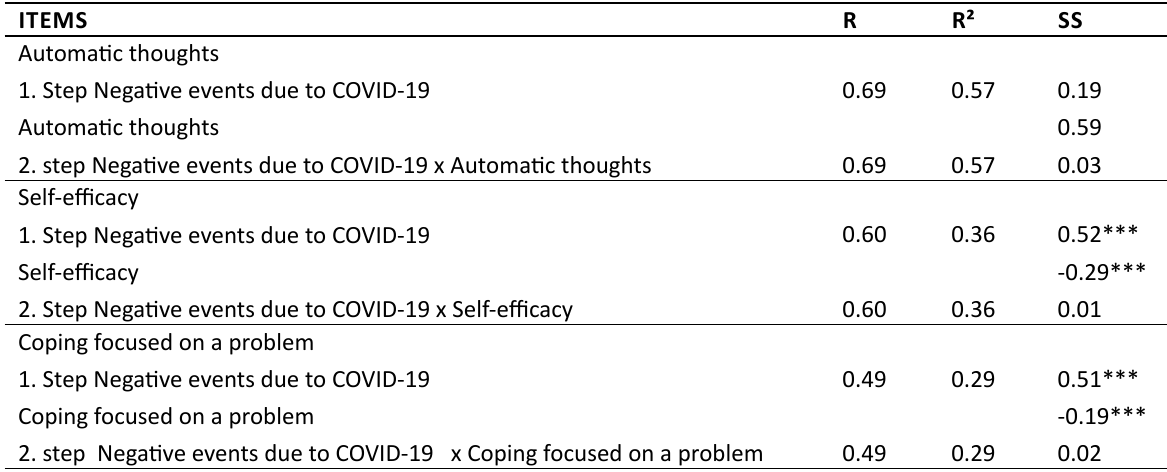
Table 3a. Hierarchical regression analysis for depression criterion variable